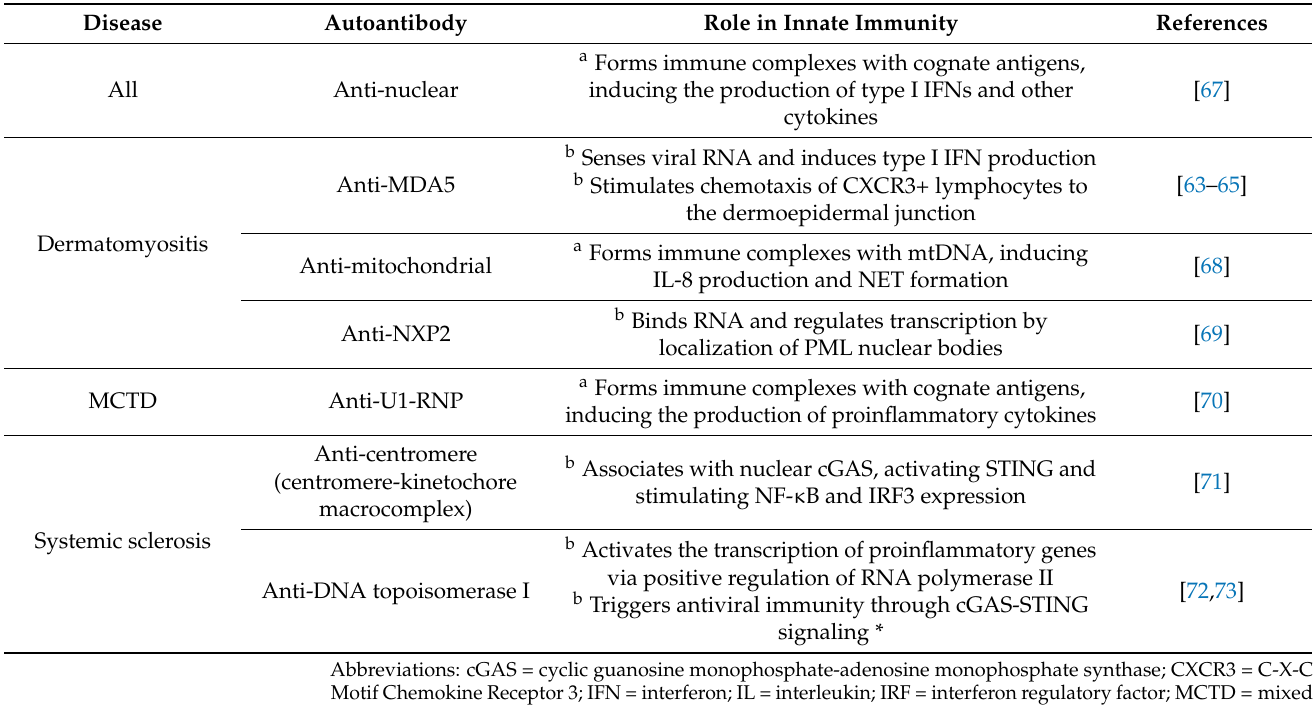
Table 1. Autoantibody associations with calcinosis